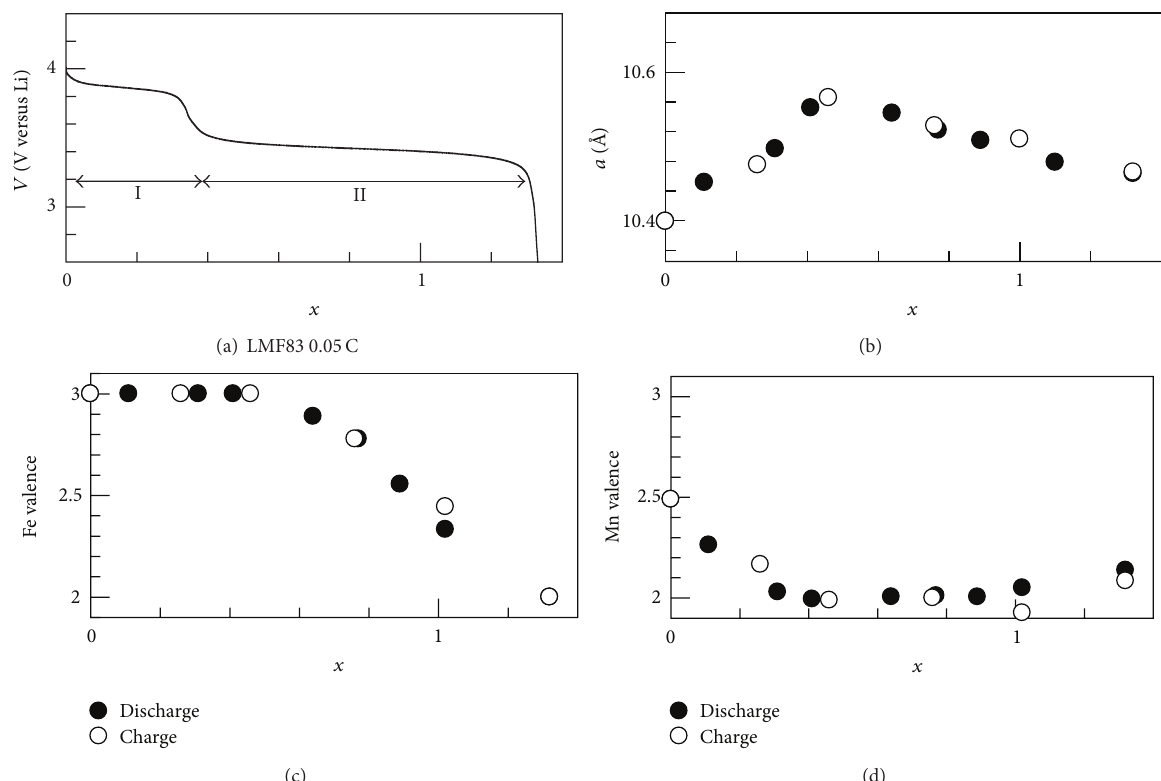
Figure 5: (a) Discharge curve, (b) lattice constant (a), (c) Fe valence, and (d) Mn valence of NMF83 against 𝑥 . Open (filled) marks in (b), (c), and (d) mean that the data are obtained in the charge (discharge) run (cited from